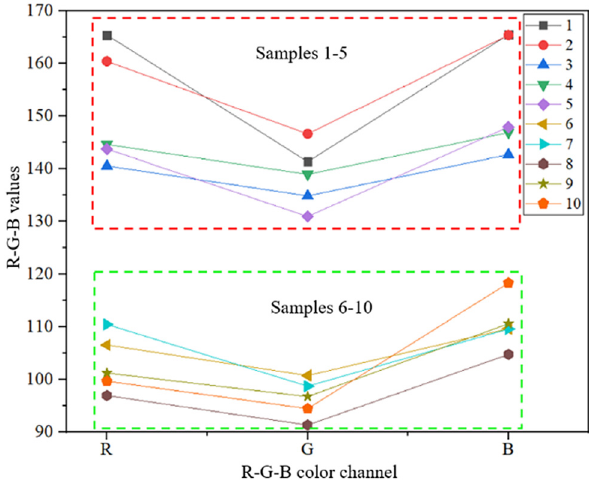
Figure 8: R - G - B numerical analysis of two modi fi